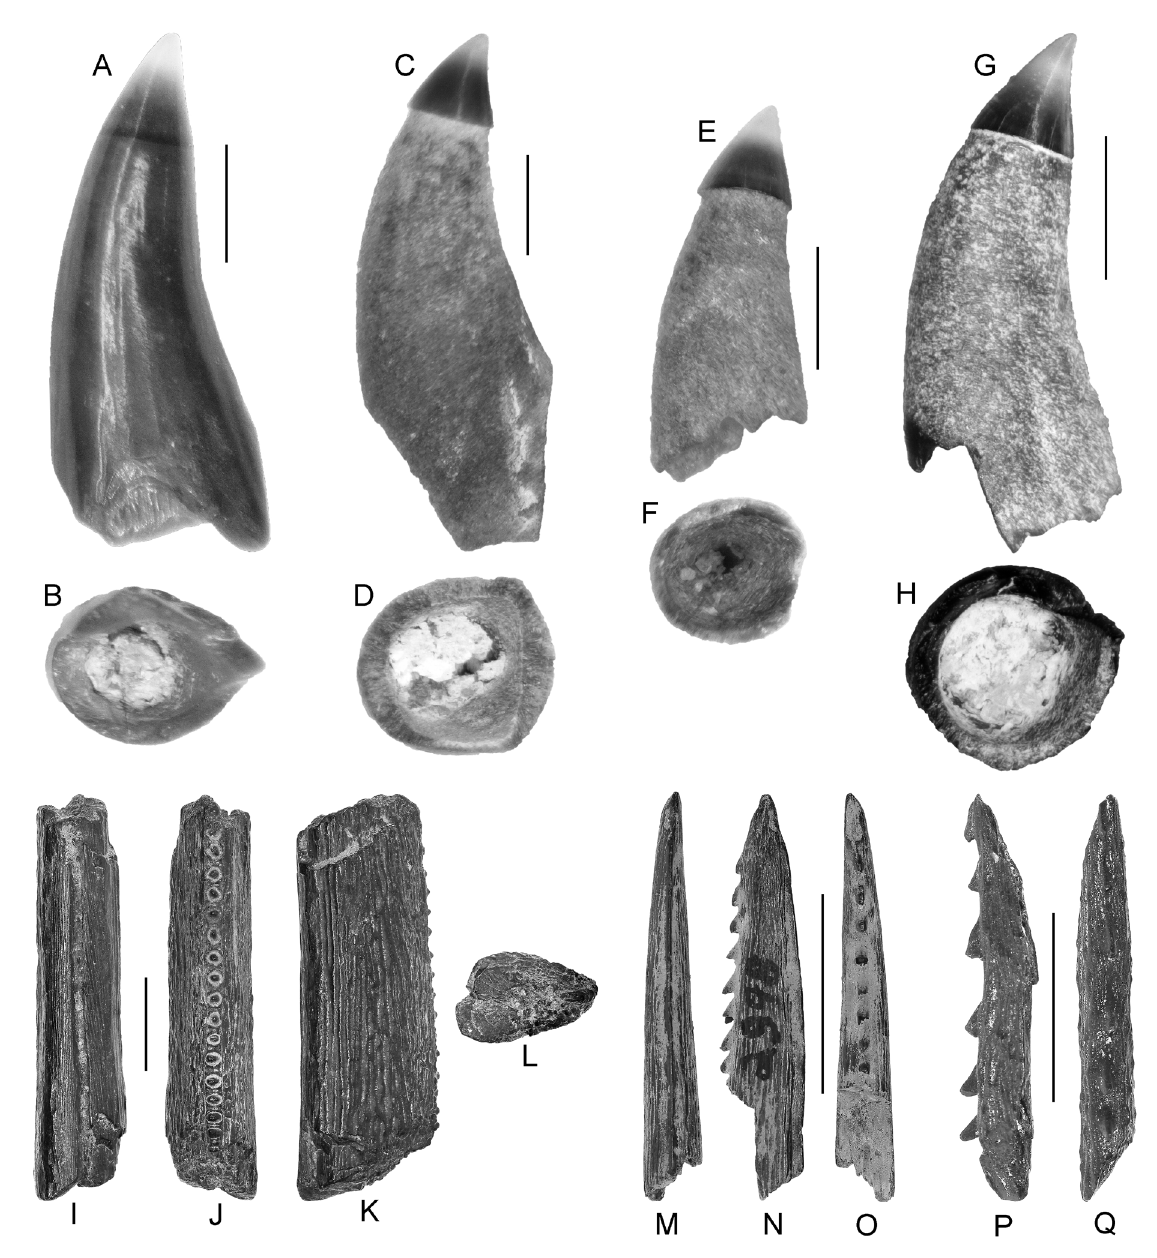
Fig. 61. Osteoglossidae Bonaparte, 1832 and Ariidae Berg, 1958, elements. A–H . Osteoglossidae. A–B . Tooth, MSC 35778.1, lower Tallahatta Formation. A . Lingual view. B . Basal view. C–D .